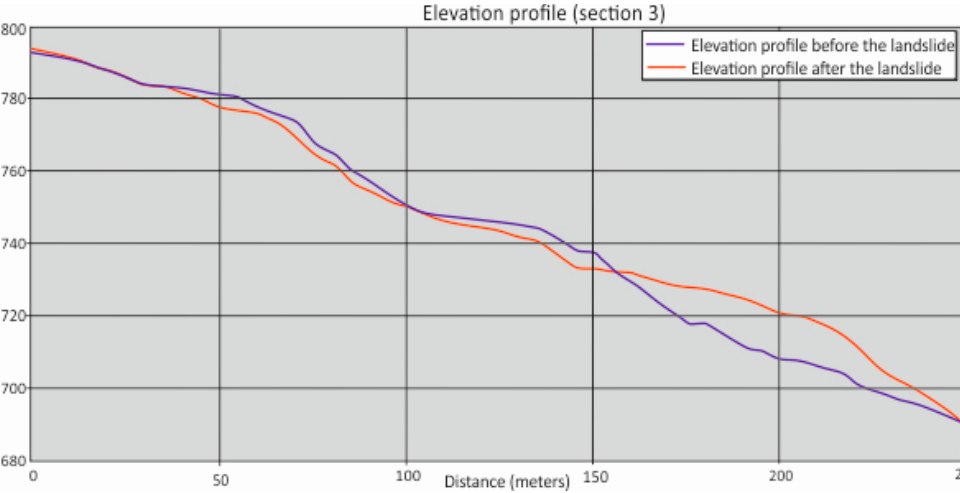
Figure 13. Elevation profiles of section 4 in Figure 11. 4.2. Monitoring 4.2.1. Orthophotos Our second concern was the continuous monitoring of the landslide area. The orthophotos resulting from the SfM processing procedure were imported in an ArcGIS environment in order to conduct its area changes. Specifically, the boundaries of the landslide were digitized aiming at the assessment of the change of the landslide over time. Digitization was based on the mapping of the landslide boundaries as well as the subsequent existence of new cracks. Figure 14 displays the evolution of the extent of the landslide from 2017 until 2020. Thus, the blue lines in Figure 14a depict the initial landslide boundaries and the displaced material as well as the boundaries of the earth road, which was constructed a few days after the landslide aiming at restoration of the circulation between Patras and Moira. The orange lines in the Figure 14b annotate the corresponding boundaries and the earth road as mapped on 19 March 2019. Based on the data of the optical imagery and their processing, the areas that display no change over time and areas where the changes are significant, e.g., the subareas A and B, can be observed. In more